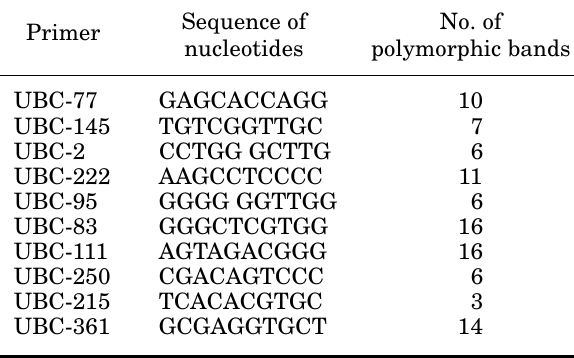
Table 2. Selected UBC primers and their nucleotide se-